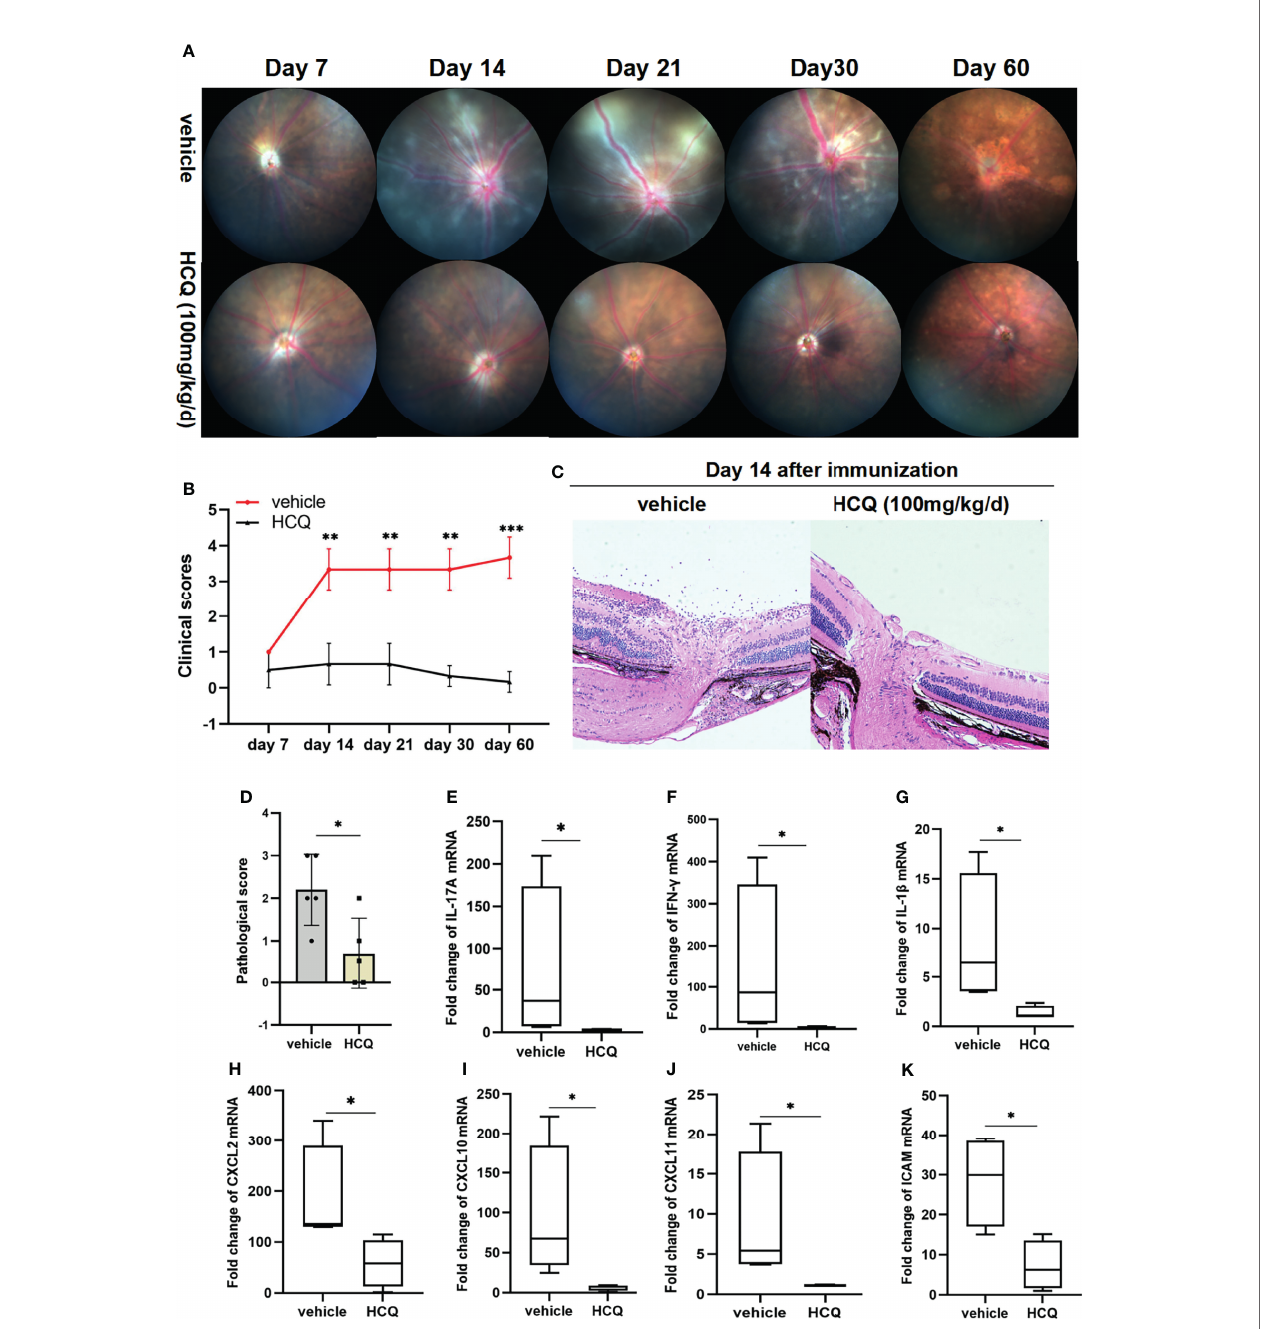
FIGURE 1 | Hydroxychloroquine (HCQ) alleviates retinal in fl ammation in experimental autoimmune uveitis (EAU). C57BL/6J mice immunized with hIRBP1-20 were treated with HCQ (100 mg/kg) or vehicle daily. (A, B) Representative photos of fundus showed attenuation of retinal in fl ammation by HCQ, characterized by fewer linear lesions and minimal vasculitis of the retina. HCQ had persistent anti-in fl ammatory effects on EAU till day 60 after immunization. The clinical scores of EAU in the two groups were evaluated and compared. (N=5). (C, D) The eyes were enucleated and prepared for staining. Representative histopathological images showing that HCQ considerably reduced the structural damages. The histopathological scores were statistically different (N=5). (E – K) RT-qPCR results showed that the expression of IL-17A, IFN- g , IL-1 b , CXCL2, CXCL10, CXCL11, and ICAM mRNAs in retina was upregulated in uveitic retinas, whereas HCQ treatment considerably decreased the mRNA expression of these genes (N=4). The data are presented as the mean ± SD (*P < 0.05, **P < 0.01, ***P <